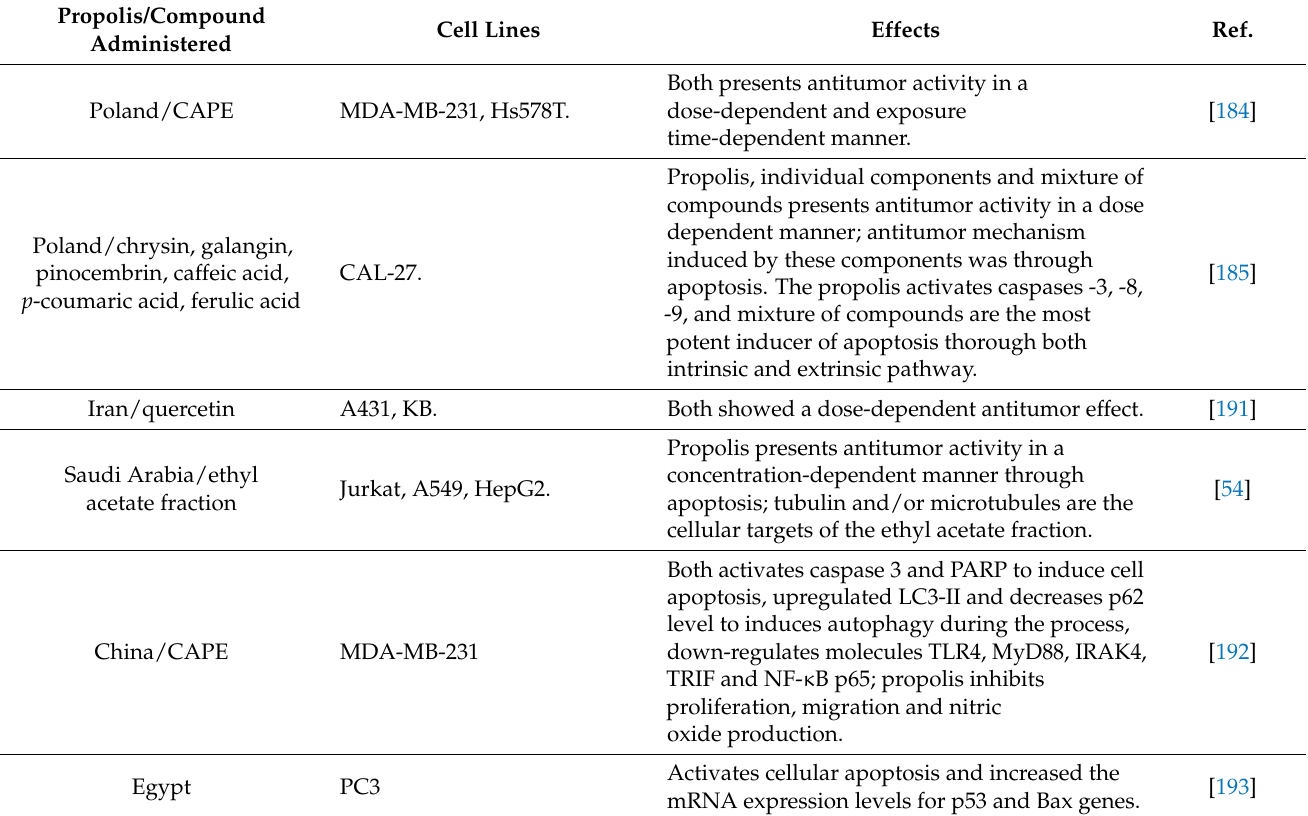
Table 8. Different propolis and their main bioactive compounds with antitumor